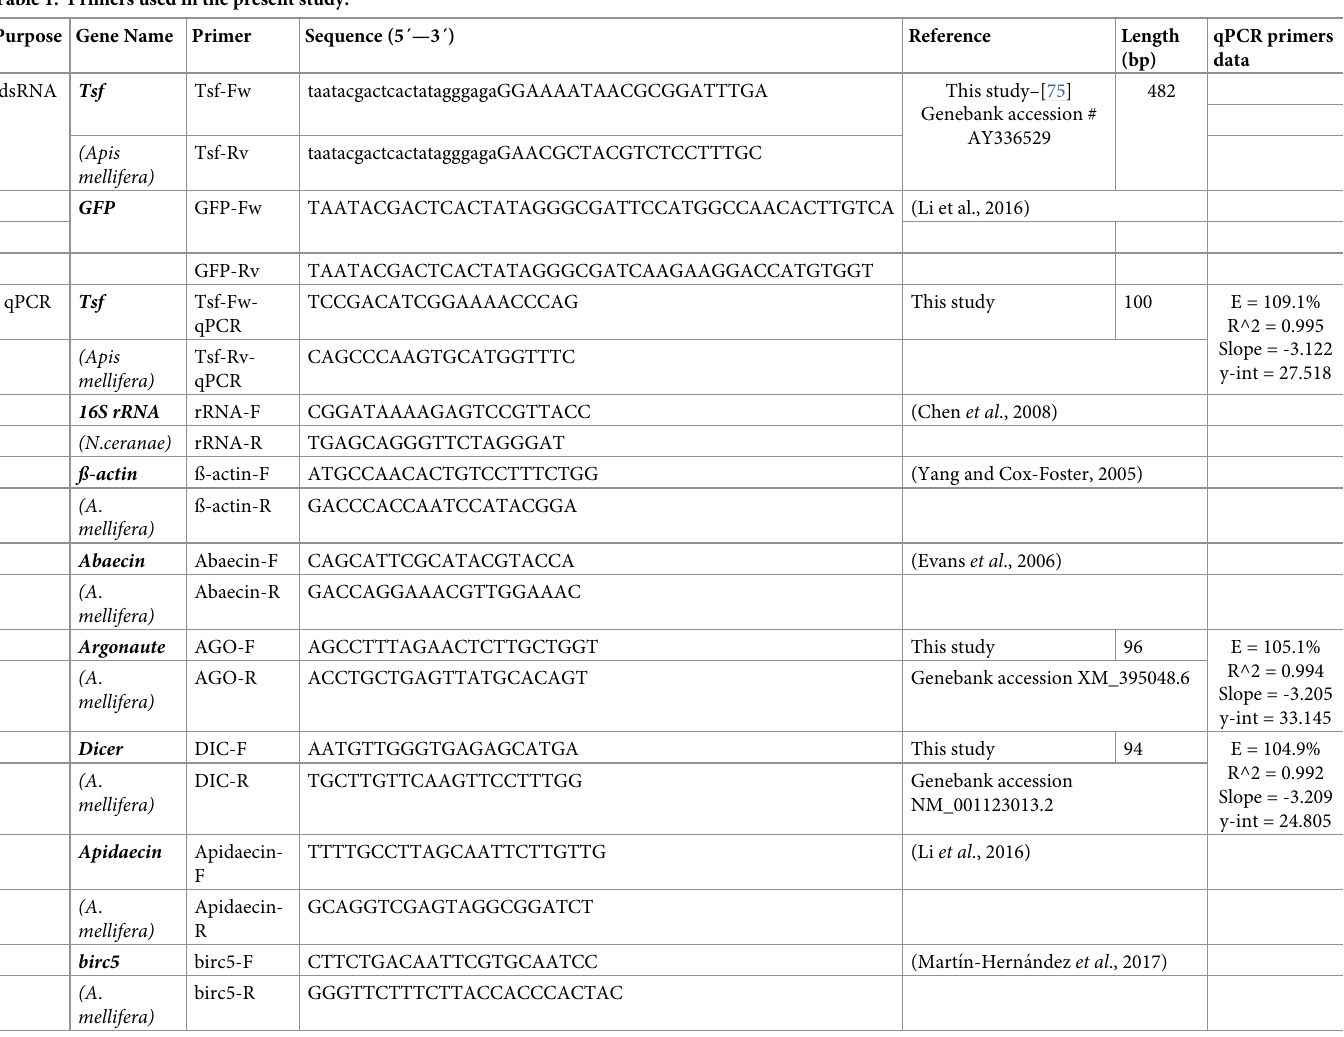
Table 1. Primers used in the present